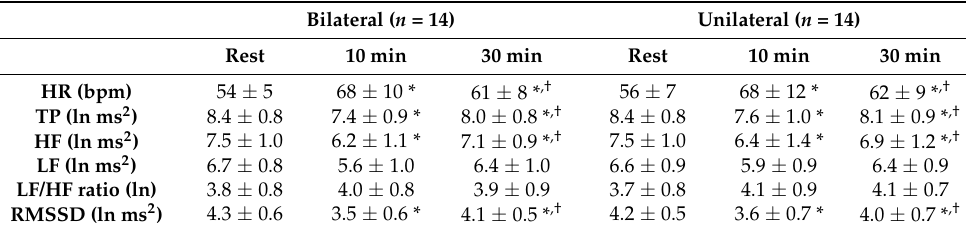
Table 3. Measures of heart rate variability at rest and during recovery from bilateral and unilateral upper body acute resistance exercise ( n = 14; Men: 7; Women: